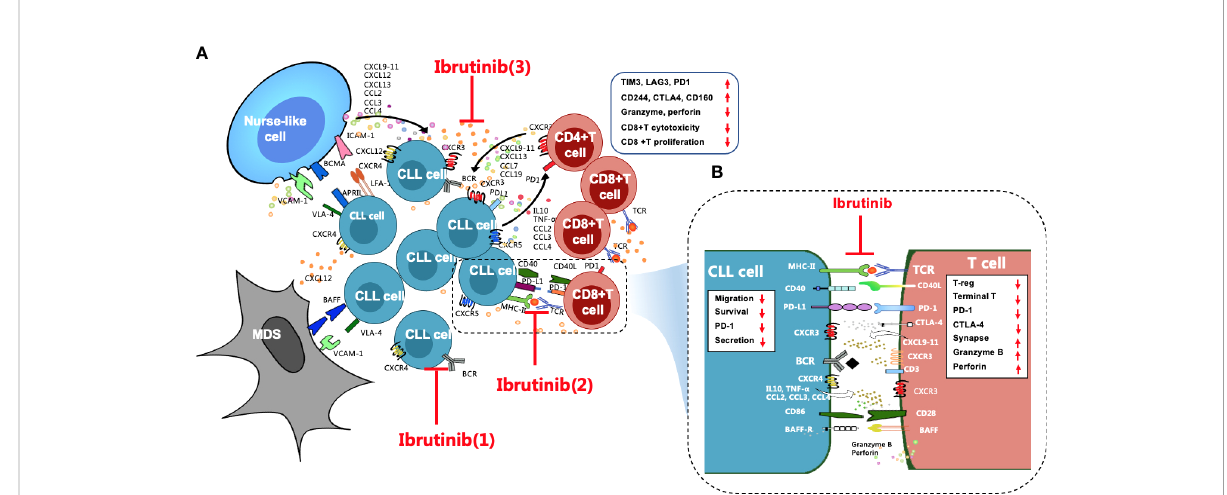
FIGURE 1 Overall regulation of ibrutinib on the CLL microenvironment, particularly T cell immunity, is important. (A) Stromal cells, NLCs, and T cells are the three key supporting cells in the CLL microenvironment. They crosstalk with CLL cells through direct contact and chemokines/cytokines and their ligand-receptor interactions, such as CXCR4/CXCL12, CXCR3/CXCL9,10,11, and CXCR5/CXCL13, to mediate the activation, homing, proliferation, and survival of CLL cells, which leads to T-cell immune dysfunction, particularly for CD8 + T cells, which are excessively activated, expanded, and gradually pseudo-exhausted. Exhausted CD8 + T cells highly express a variety of inhibitory receptors, such as PD1, CTLA4, CD244, TIM3, and LAG3. The cytotoxicity and proliferation activity of CD8 + T cells decrease. Ibrutinib regulates the CLL microenvironment by (1) blocking BCR signaling, (2) preventing direct contact between CLL cells and T cells and repairing impaired immune synapses, and (3) inhibiting cytokine networks. (B) These effects contribute to improving the activity of effector T cells in CLL patients, such as increased granzyme B and perforin secretion, reduced inhibitory receptors, etc. In addition, ibrutinib inhibits the cytokine secretion, migration, proliferation, and survival of CLL